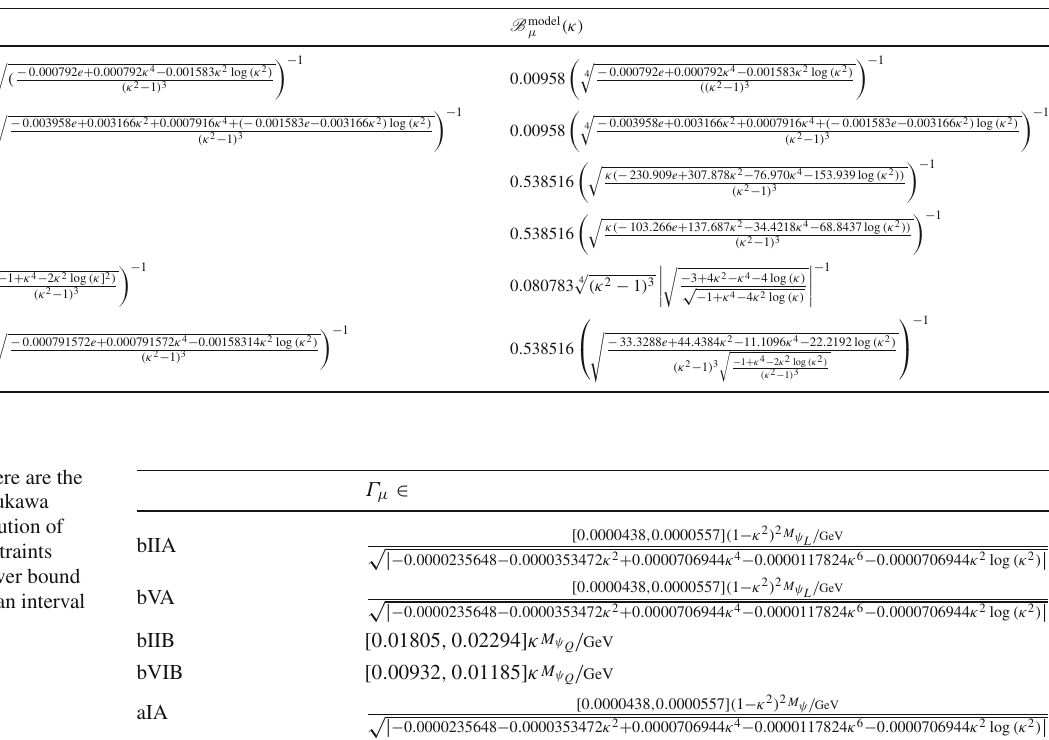
. The entries of this table represent the upper bound b